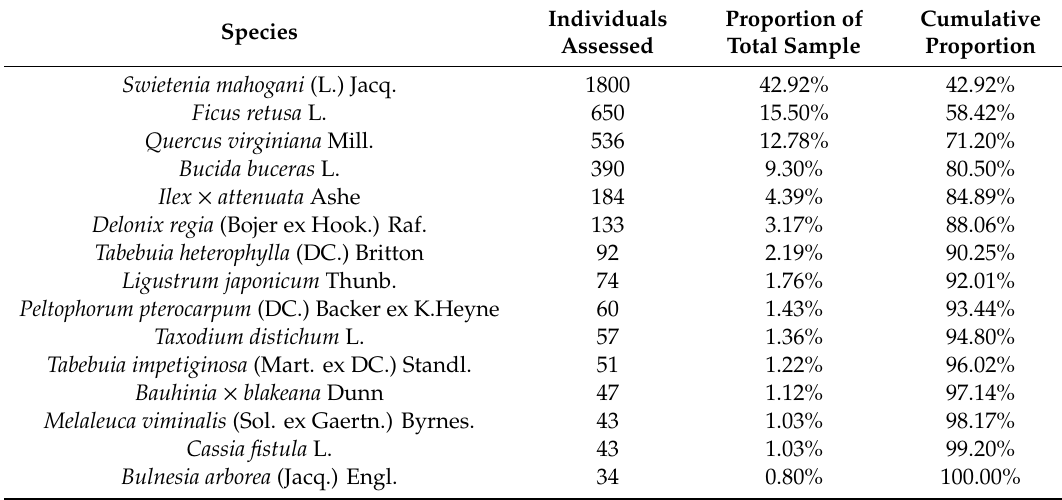
Table 1. Count of individuals within each species assessed prior to the passage of Hurricane Irma in Naples, Florida, USA. Only species with at least 30 individuals are included; species are arranged in descending order of their proportion of the total sample ( n = 4194). Species